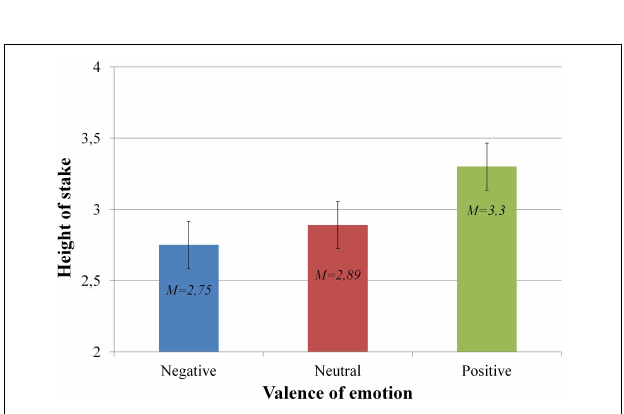
FIGURE 2 | Differences between heights of stakes divided by the emotional charge valence of the preceding